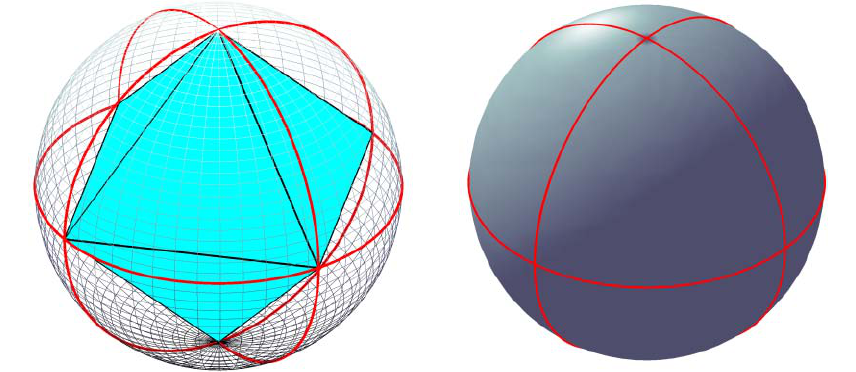
Figure 11. The octahedron version of the initial global